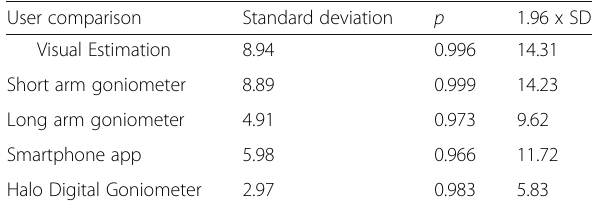
Table 1 Comparison of minimum significant difference between methods of measurement (standard deviation in degrees between measurements, 1.96 x standard deviation used for minimum significant